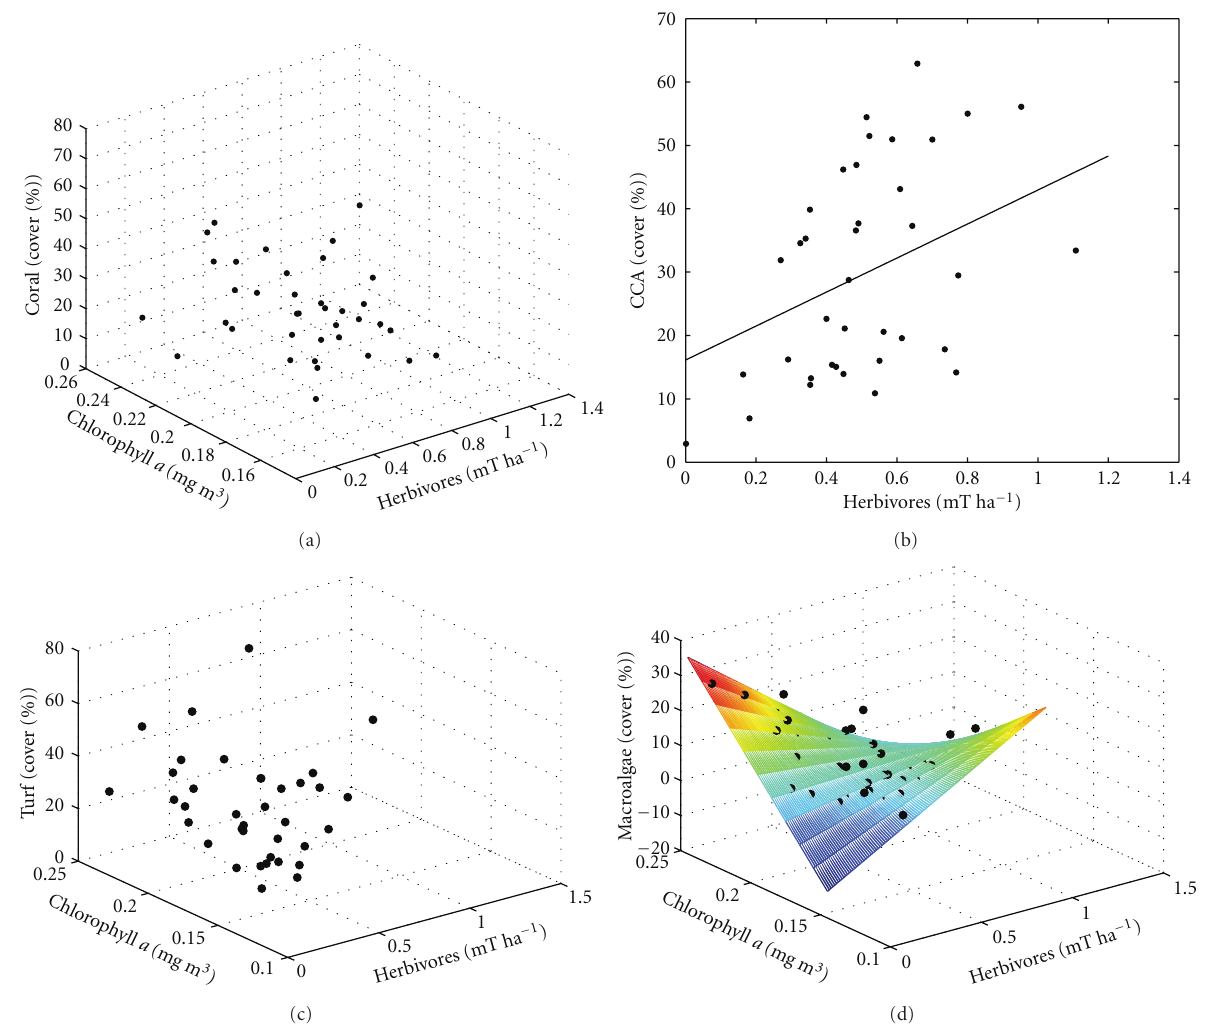
Figure 4: The e ff ect of herbivores and chlorophyll- a on benthic functional groups. (a) Coral was not significantly a ff ected by herbivores, chlorophyll- a , or their interaction, (b) CCA and fitted values (black line) as a function of herbivore biomass ( P < . 01) (pseudo R 2 = 0 . 59, P < . 05), (c) turf was not significantly a ff ected by herbivores, chlorophyll- a , or their interaction, and (d) macroalgae and fitted values (rainbow mesh) predicted by herbivores ( P < . 01), nutrients ( P < . 001), and an interactive term ( P < . 01) ( R 2 = 0 . 56, P < . 0001). See Tables S6 and S7 in Supporting Information for model selection and detailed